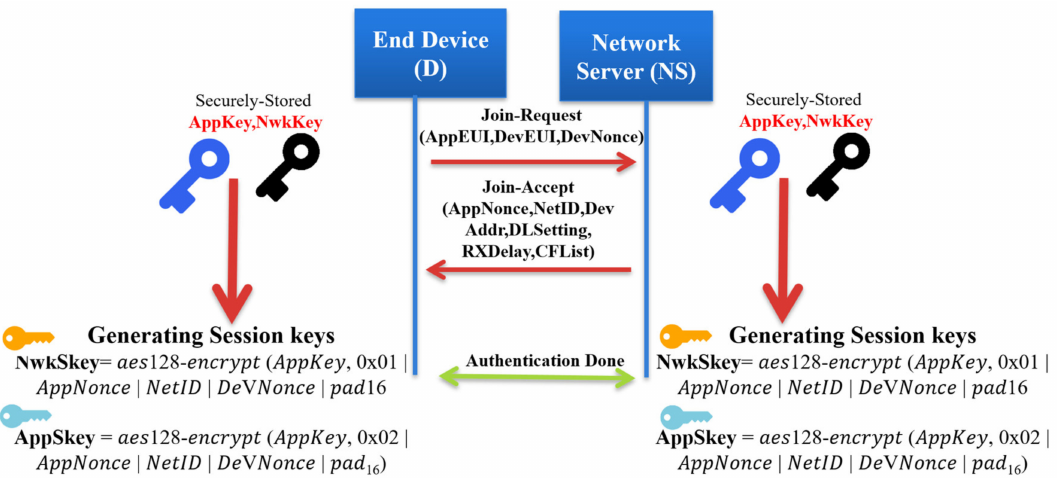
Figure 2. Over-The-Air Activation in LoRaWAN networks.